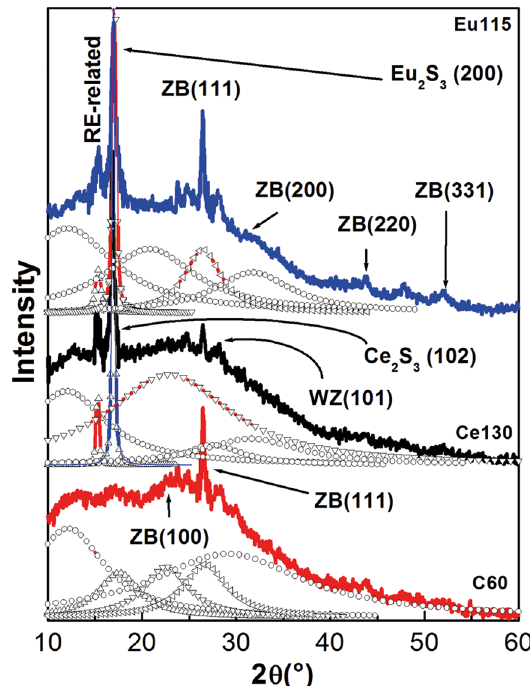
Figure 2. a) It shows the C60 diffractogram that displays peaks at: 2 θ = 26.8, 44.2 and 52.4°. These are related to the (111), (220) and